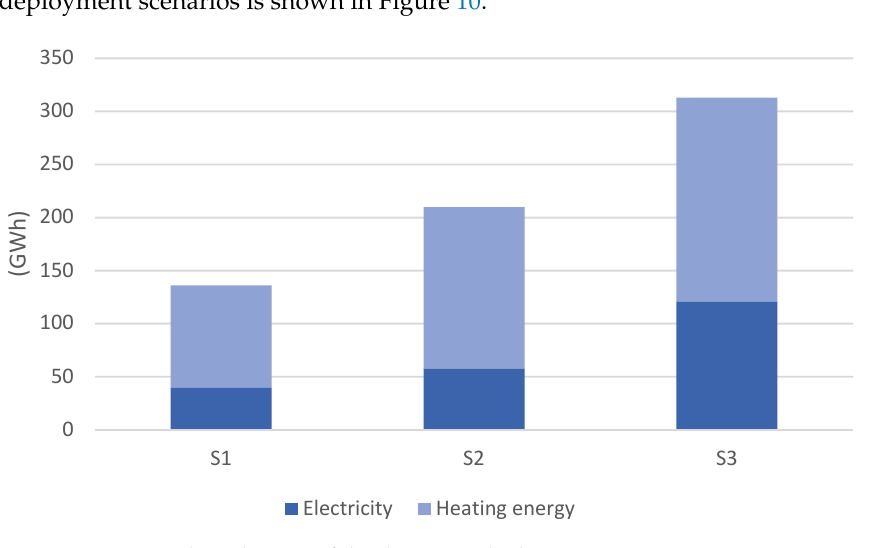
Figure 10. Potential production of the three RES deployment scenarios.